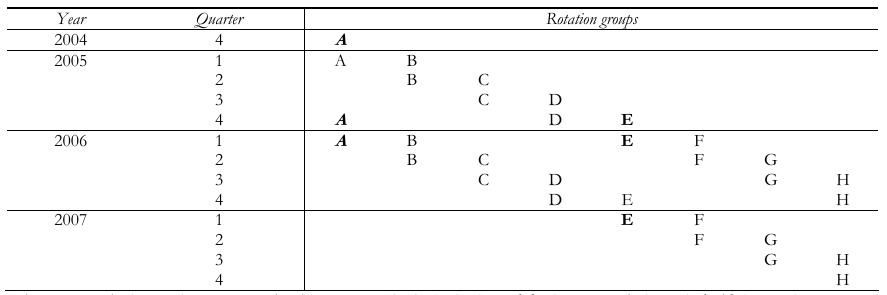
The rotation scheme of the Italian LFS (